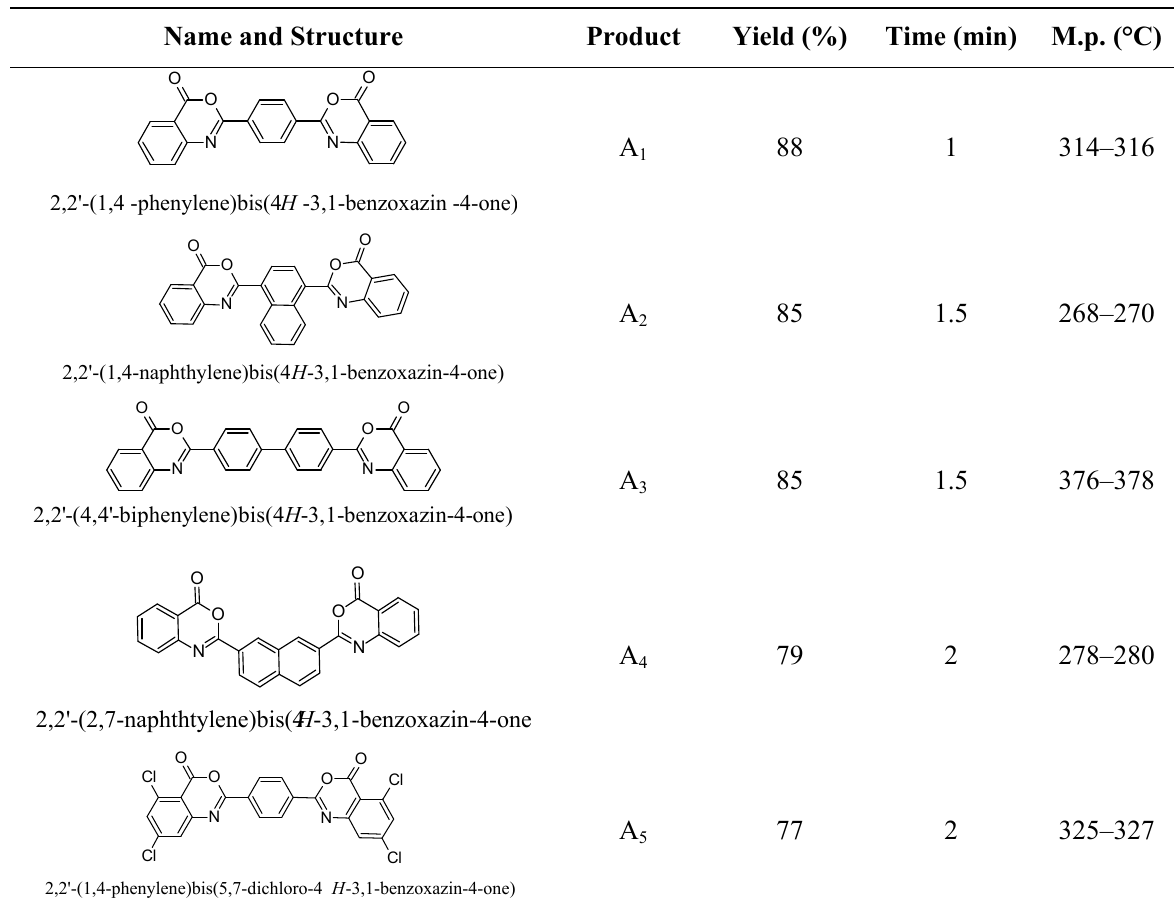
Table 1. Yield, Time of Reaction (Power 350 W) and Melting